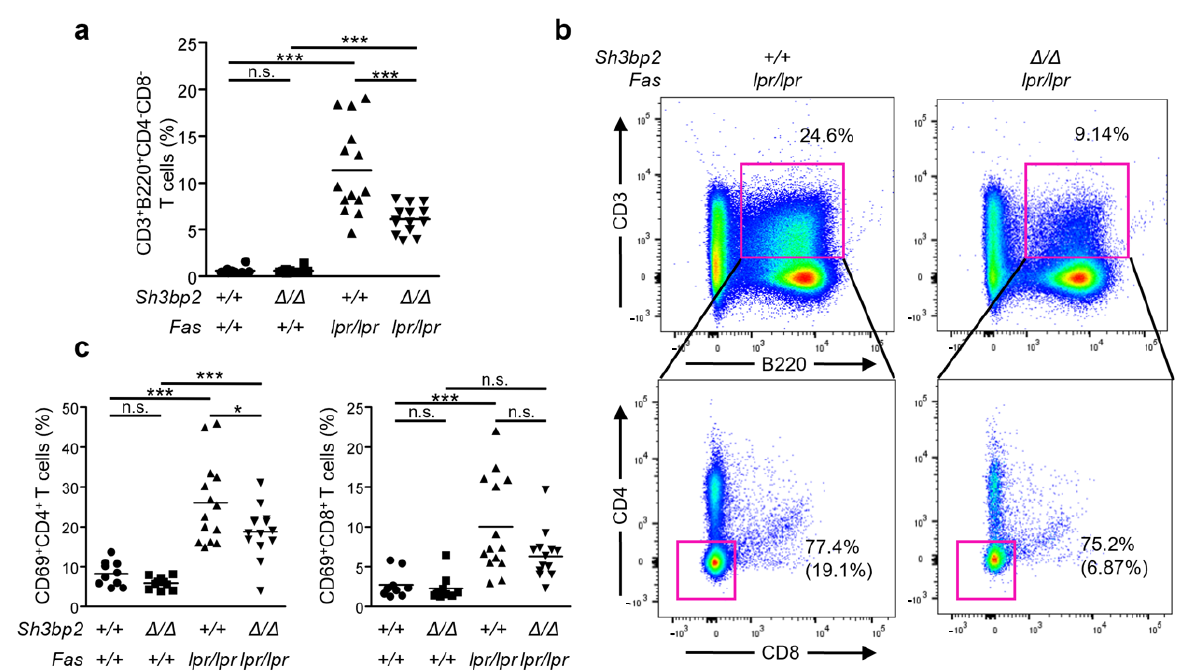
Figure 3. Aberrant accumulation of CD3 + B220 + CD4 - CD8 - cells is improved in Sh3bp2 ∆ / ∆ Fas lpr/lpr mice. Spleen cells were collected from Sh3bp2 +/+ ( n = 10), Sh3bp2 ∆ / ∆ ( n = 10), Fas lpr/lpr ( n = 14), and Sh3bp2 ∆ / ∆ Fas lpr/lpr ( n = 14) mice at 35 weeks of age. T cell subsets were stained with fluorochrome-labeled antibodies against CD3, CD4, CD8, B220, and CD69. ( a ) The ratios of T cell subsets in the spleen were analyzed by flow cytometry. All the cells were gated on lymphocytes. ( b ) Representative flow cytometry plots of CD3 + B220 + CD4 - CD8 - cells (double negative T (DNT) cells) cells. After gating CD3 + B220 + cells, the ratios of CD4 - CD8 - cells are defined as indicated by red rectangles. The numbers in parentheses indicate the percentages of DNT cells in total lymphocytes. ( c ) The ratios of CD69 + CD4 + or CD8 + T cell subsets were determined. Each dot denotes an individual mouse, and horizontal lines represent the means. * p < 0.05; *** p < 0.001; n.s.= not significant.